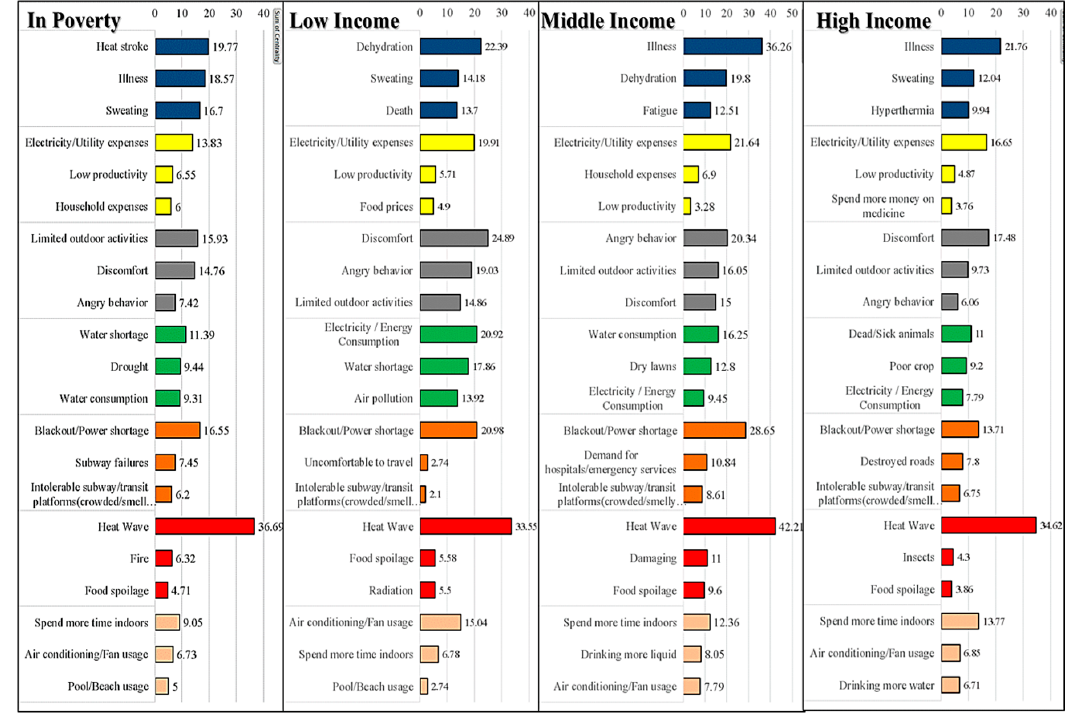
Figure 9. Concepts of highest centrality in the network per sector and income group. The colors refer to following sectors: health, economic aspects, social aspects, energy and natural resources, infrastructure, hazard and damages, life style.